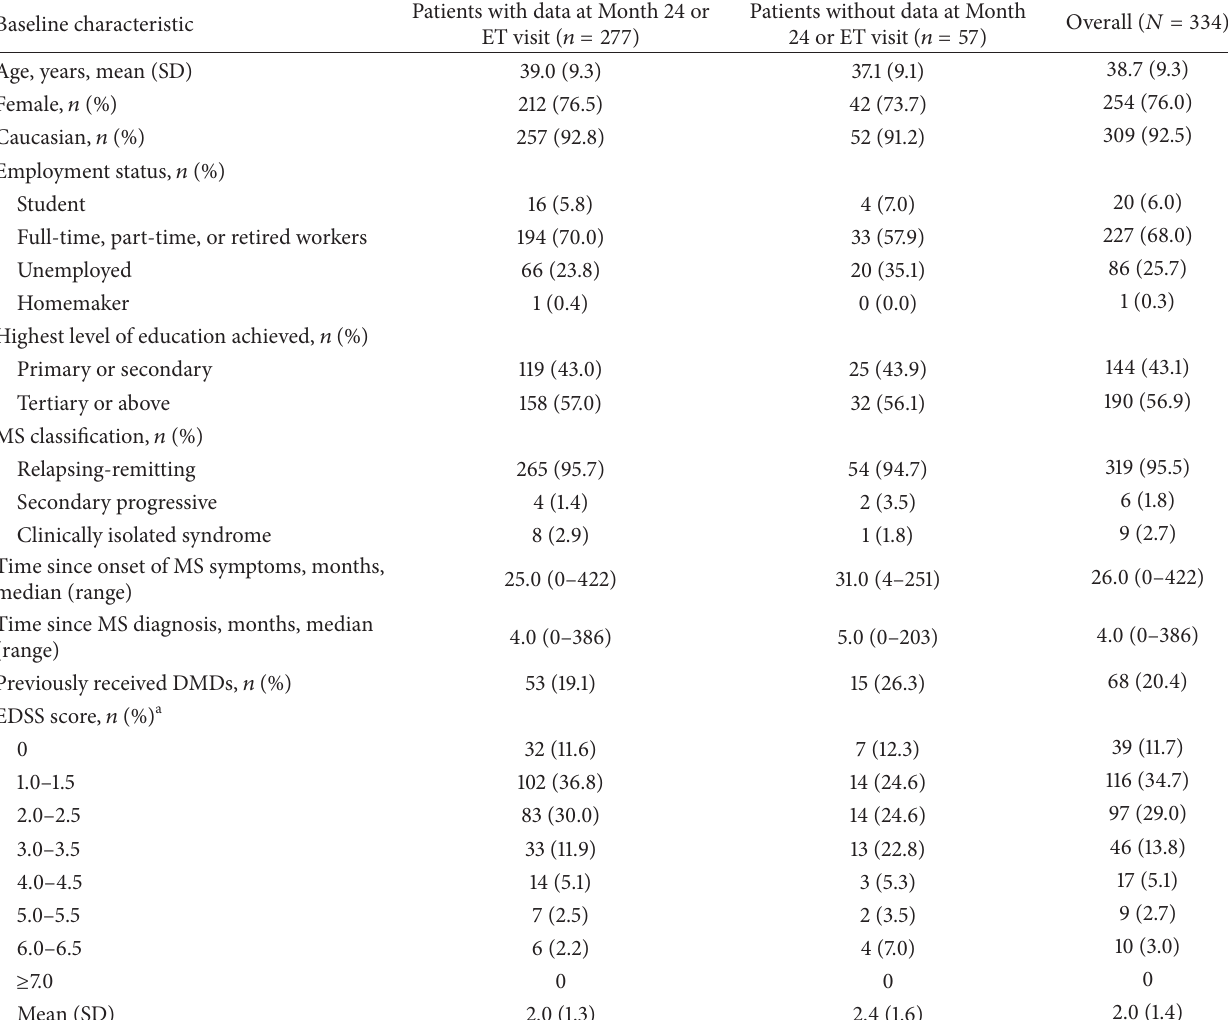
Table 1: Baseline demographics and disease characteristics